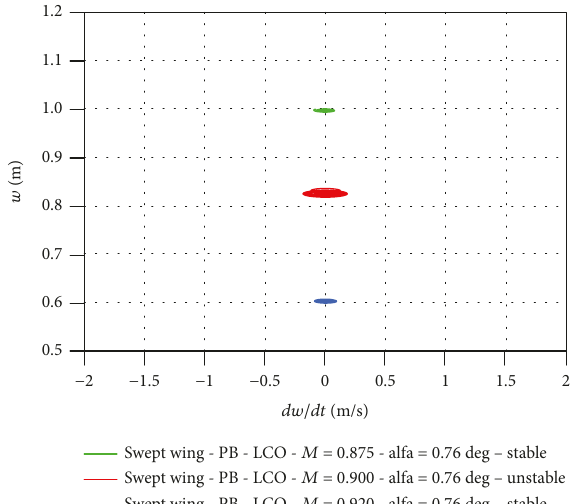
Figure 35: FSI analyses of the curved wing — Case 2 (cruise — tip displacement LCO — PB).